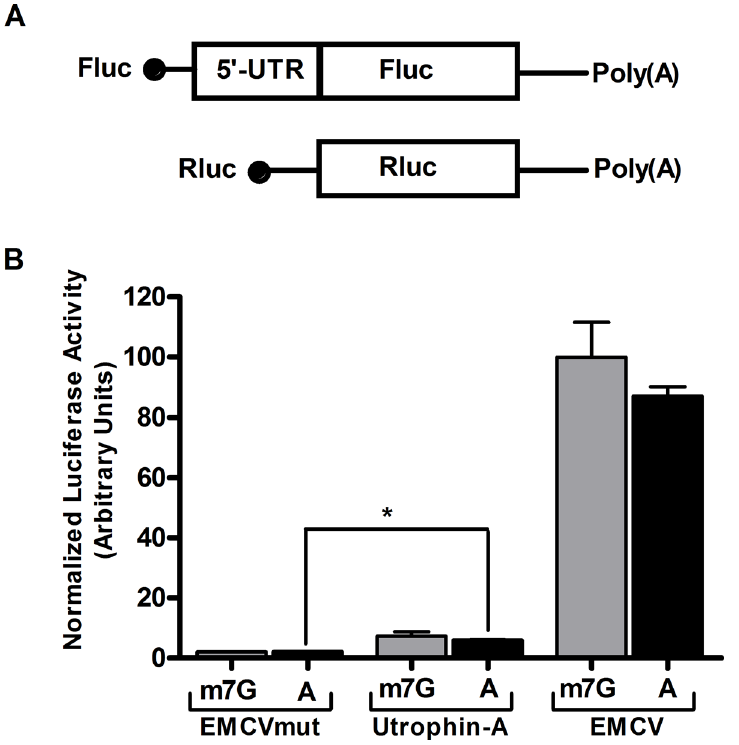
Fig 1. Comparison between cap-dependent and IRES dependent translation of utrophin-A 5'-UTR containing reporter. (A) Schematic presentation of monocistronic mRNA pairs used in the assay. Fluc: Firefly luciferase, Rluc: Renilla luciferase. To normalize activities of m7G-capped and A-capped Fluc constructs containing the tested 5'-UTRs, the m7G-capped Rluc was used as reference. (B) Comparison of indicated m7G-capped vs. A-capped monocistronic transcripts in the RNA transfection assay for mouse C2C12 cells, where utrophin-A 5'-UTR is compared with EMCV IRES. The relative A-capped Fluc/m7G- capped Rluc luciferase activity indicates IRES activity of the 5'-UTRs. Results presented as mean ± SD (n = 6). Student ’ s t test was used to analyze the data. The asterisk denotes the statistically significant (P < 0.0001) IRES activity of utrophin-A 5'-UTR compared to negative control